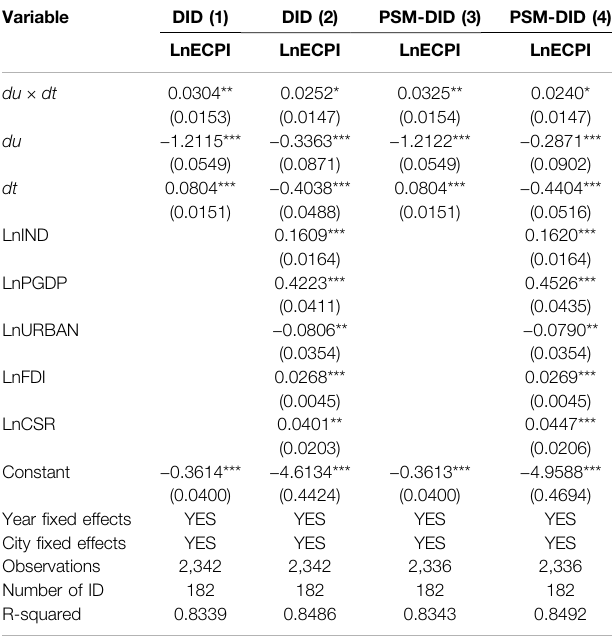
“ Ln ” in the table denotes the logarithmic form of the variables. *, **, and *** indicate signi fi canceatthelevelsof10%,5%and1%,respectively.Thevaluesinparenthesesare standard errors. The same as